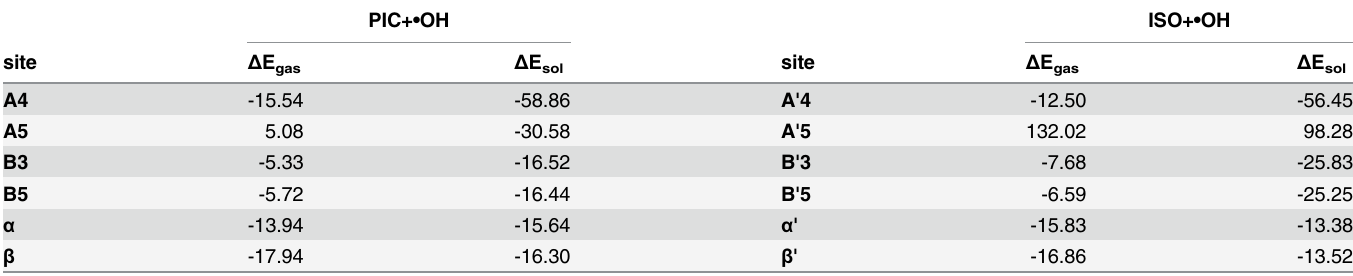
Table 3. The barrier heights of TS with zero-point energy corrections for reactions of PIC and ISO with (cid:129) OH in the gas phase and water (in kJ/mol).